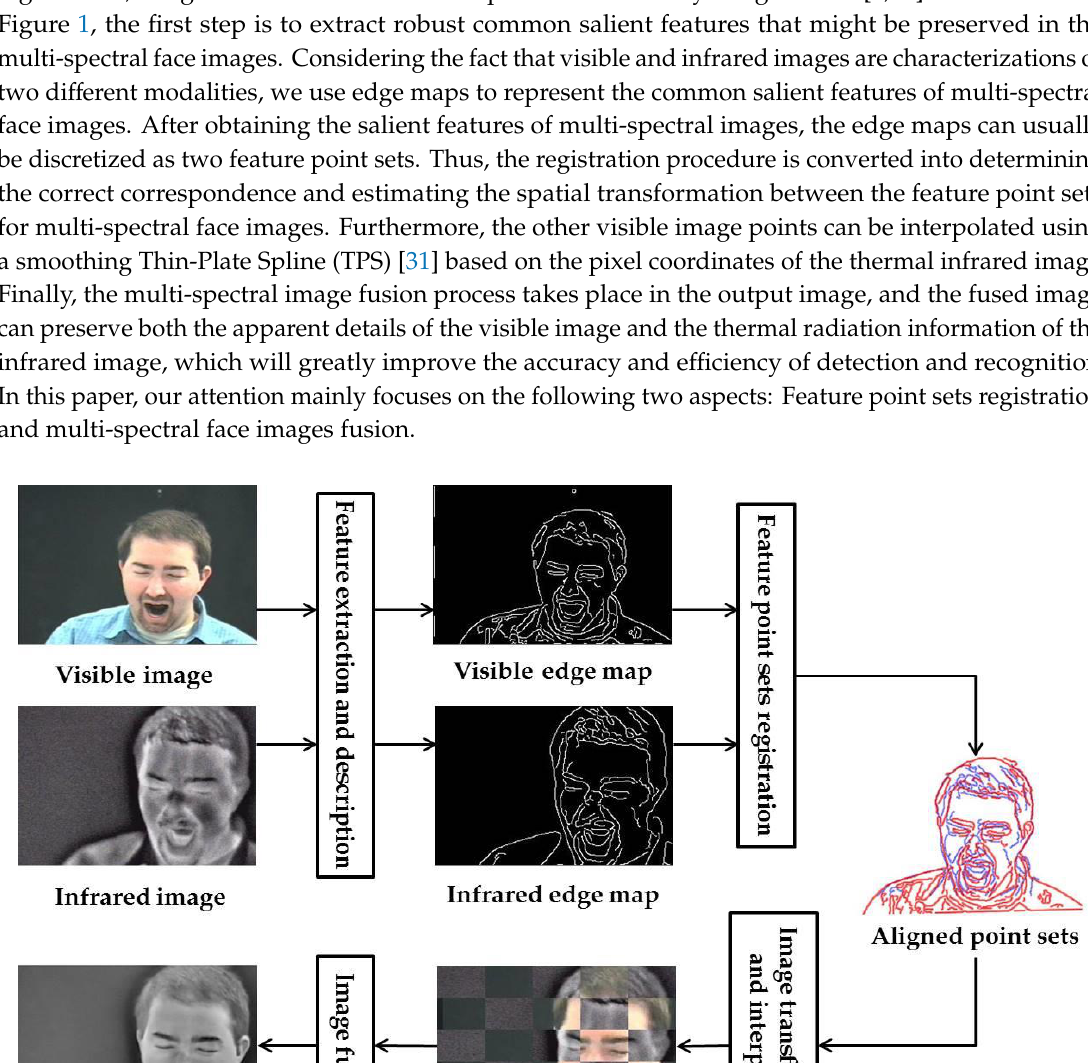
n d = 5 denotes the numbers of logarithm distance